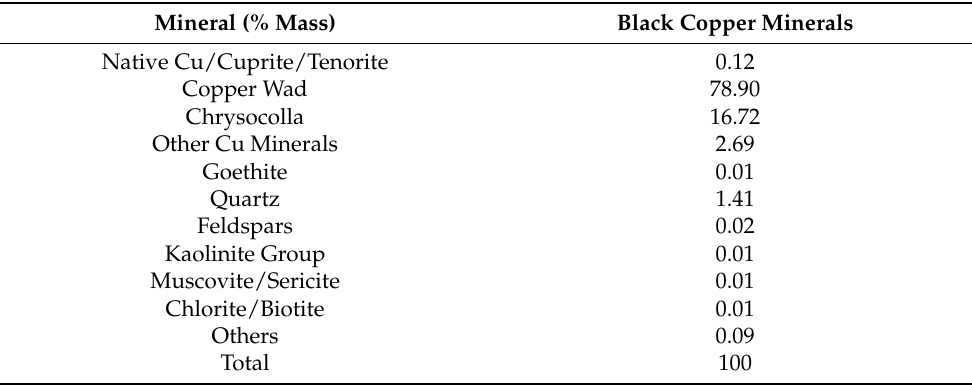
Table 3. Mineralogical composition of the black copper mineral. Mineral (% Mass) Black Copper